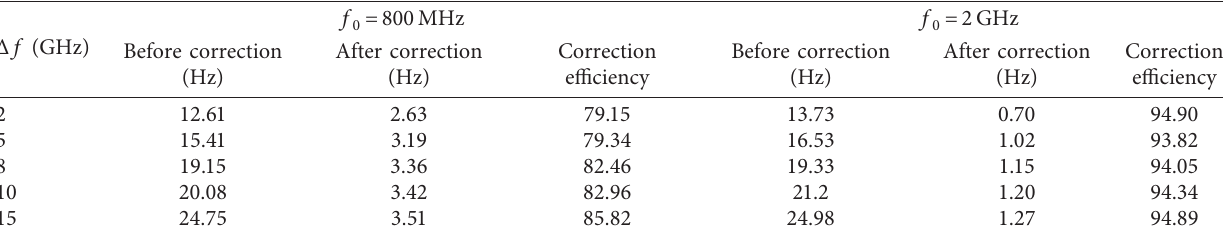
Figure 5: Errors in measured FDOA corrected by the proposed method. Table 3: Comparisons of correction efficiency in the measured FDOA